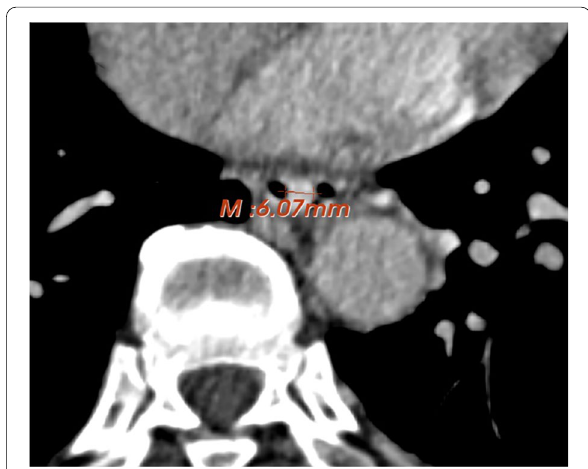
Fig. 1 Severe EV according to endoscopy in a 66-year-old man with liver cirrhosis (severe of endoscopy, maximum minor axis 6.07